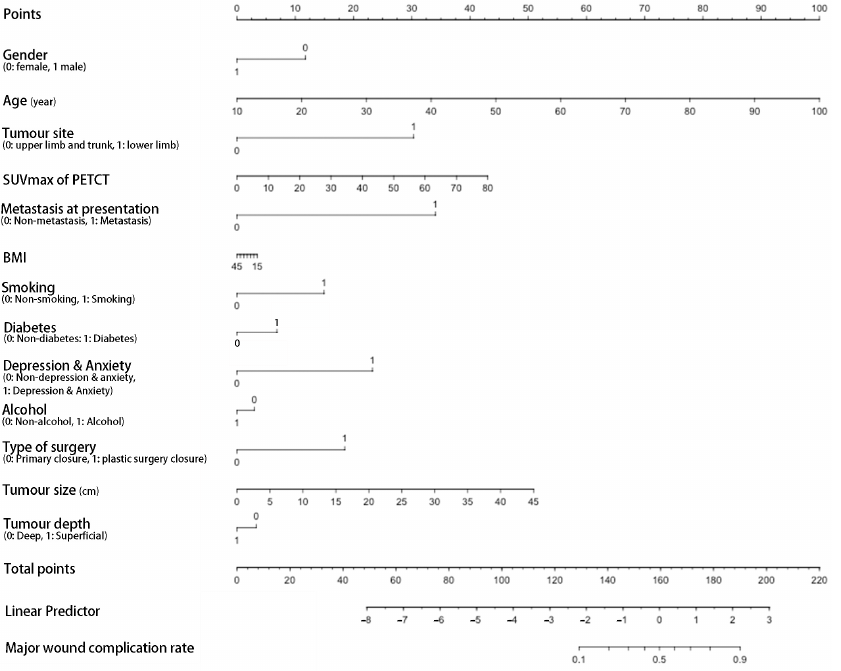
Figure 3. Nomogram 1 for prediction of postoperative major wound complication after preoperative radiotherapy and surgery. The point of each predictor could be assessed at the first line (Points) and the total points then could be calculated by summing up the points of each predictor and identified on the penultimate line. At last, the rate of MaWC could be assessed by the corresponding total points at the last line. BMI, body mass